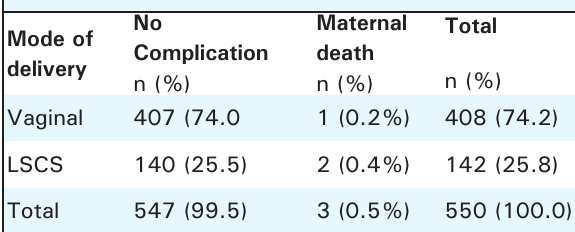
Table 6. Mode of delivery versus maternal